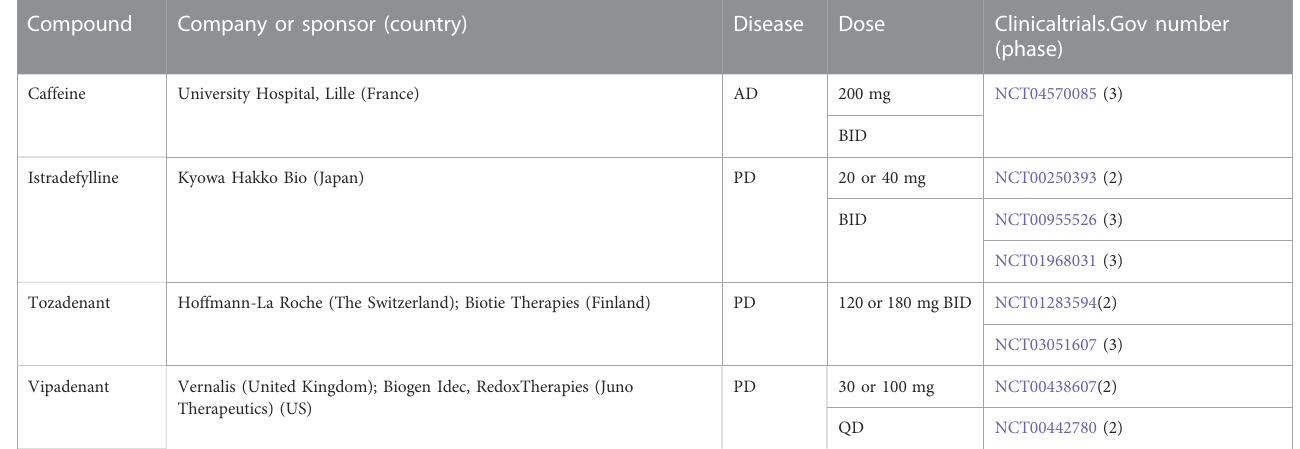
TABLE 3 BBB-permeable A 2A -related compounds under clinical trials in neurodegenerative diseases.